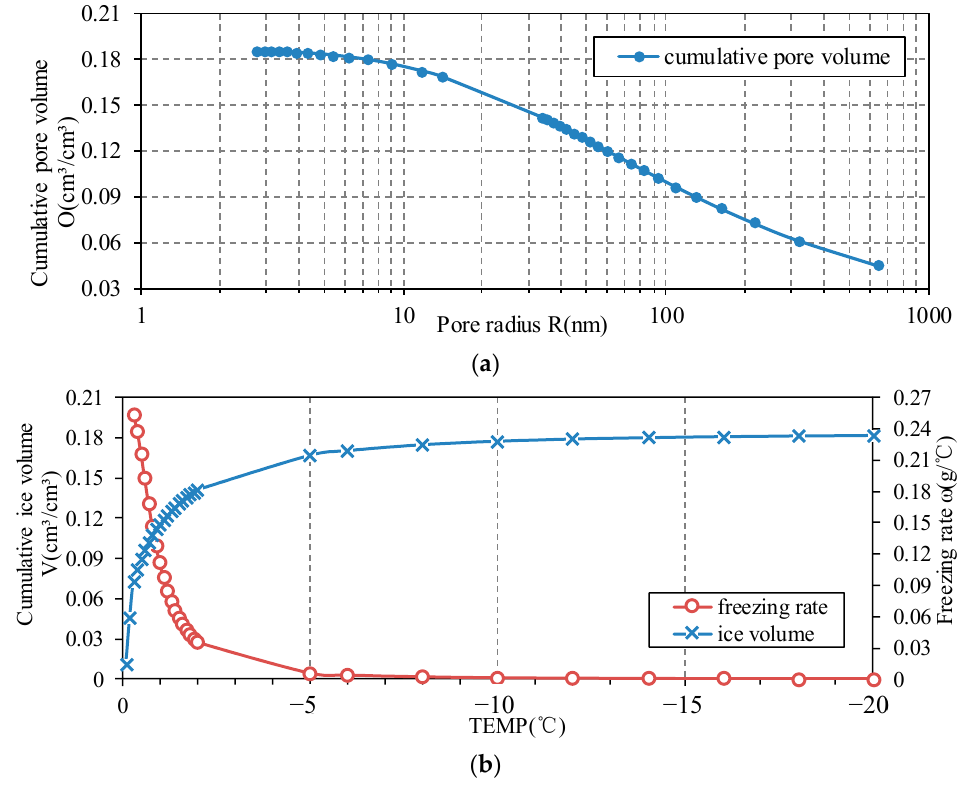
Figure 5. ( a ) Temperature distribution of Mortar specimen; ( b ) Freezing volume and freezing